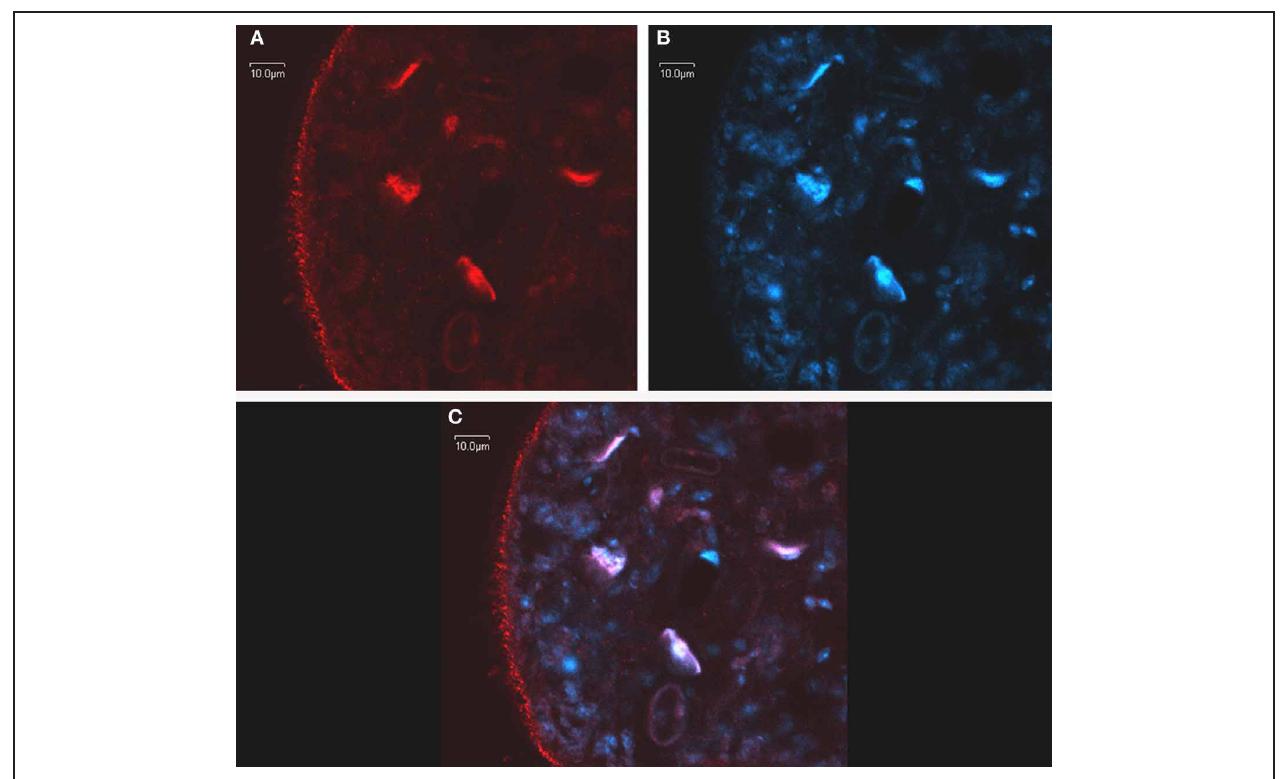
( Invitrogen ) (B) . Merged images from (A) and (B) showing colocalisation of MvFABPs and the nucleus. Violet regions indicate areas of colocalisation (C) . Images were taken at 90X magnification. Bars indicate 10 microns.